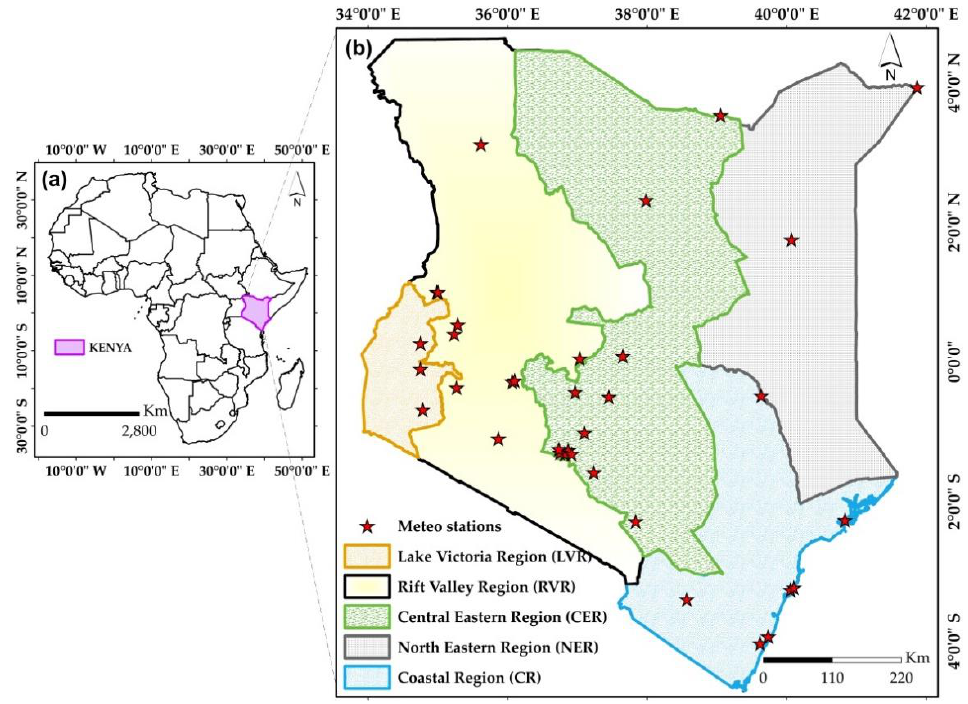
Figure 1. Map of the study area: ( a ) position of Kenya within Africa ( b ) the regions of Kenya.